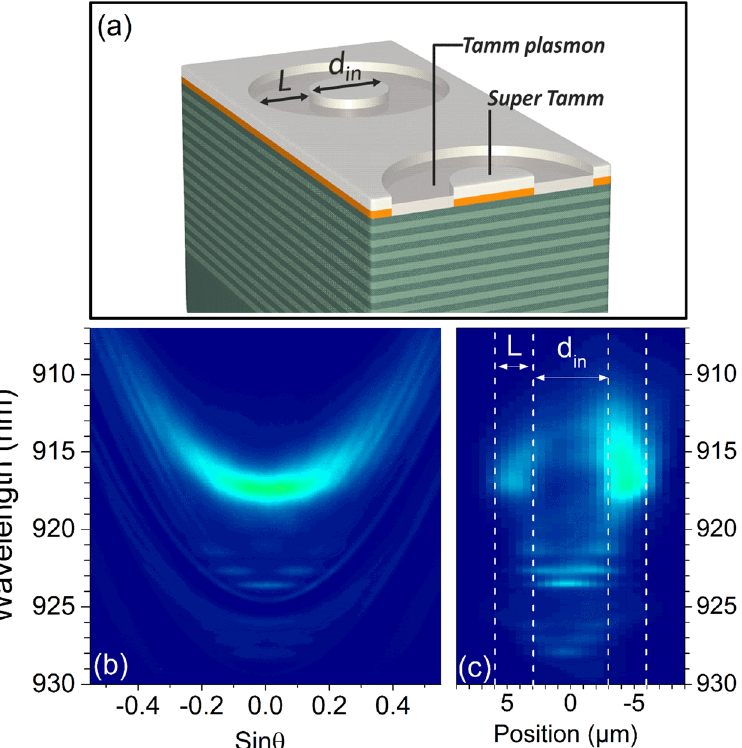
Figure 4. ( a ) Schematic representation of the sample evidencing the DBR, the PMMA resist layer (e = 35 nm) and the 45 nm silver layer. Rings of inner diameter d in and arm width L are defined in the PMMA layer. ( b ) Experimental emission dispersion relation recorded on a ring of inner diameter d in = 6 µ m. ( c ) Wavelength- resolved emission as a function of the position along the diameter of the ring.